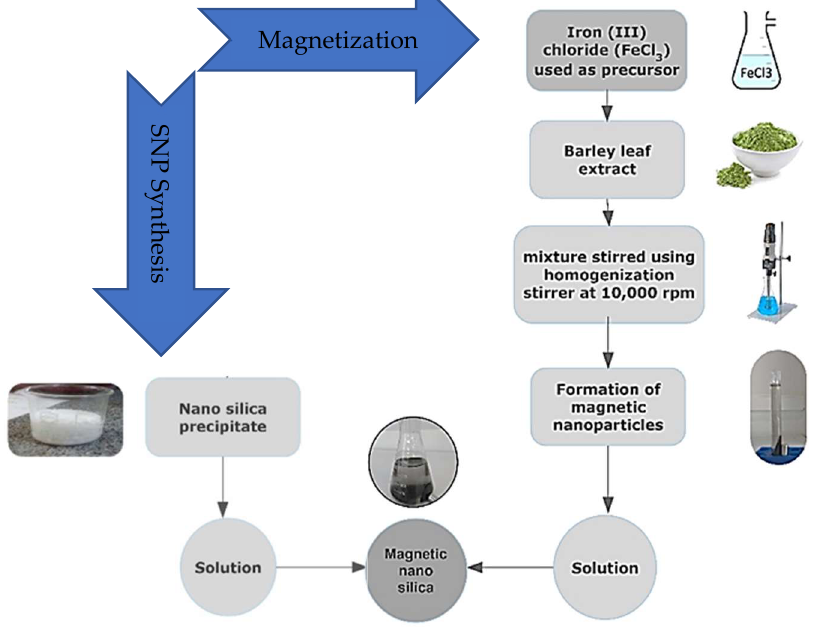
Figure 2. Schematic diagram of the experimental procedure to produce magnetic nano-silica. Adapted, in part, with permission from Ref. [30]. 2020, Akhayere et. al.